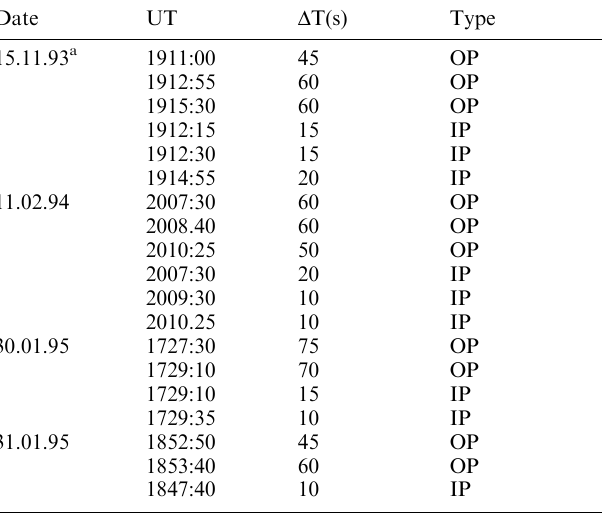
Table 1. Parameters of OP and IP events. UT indicates the beginning of the event, (cid:68) T is the event